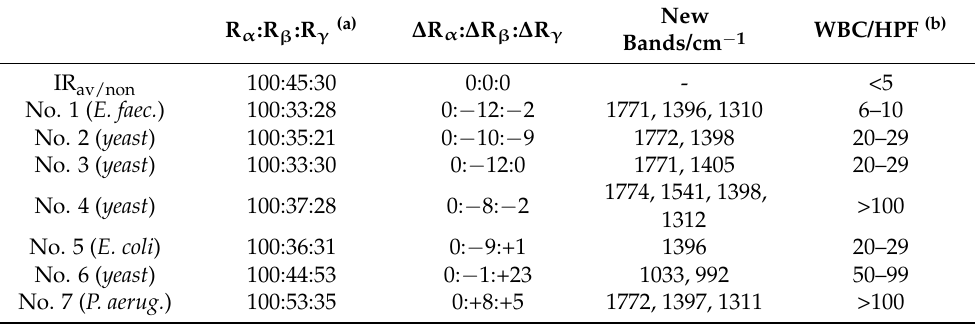
Table 2. Comparison of ratios of intensities for bands near 1625 cm − 1 ( α ), 1456 cm − 1 ( β ), and 1075 cm − 1 ( γ ), and new bands observed in ATR-FTIR spectra of